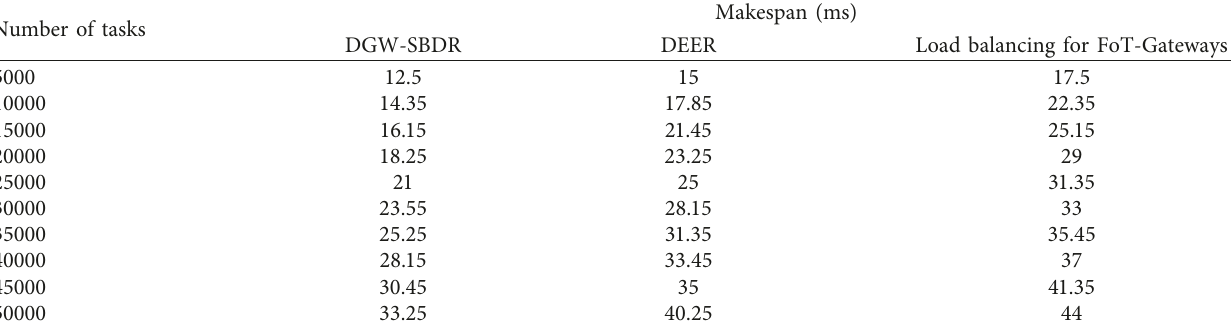
Figure 4: Average load balancing efficiency. Table 4: Simulation results for makespan.